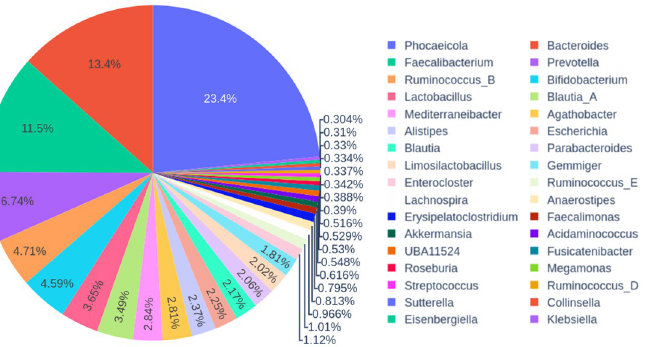
Fig 2. Piechart summarizing the taxonomic composition at the genus level for the top 100 highly expressed genomes. Phocaeicola is the most abundant phylum (23.4%, purple), followed by Bacteroides (13.4%, red), Faecalibacterium (11.5%, green), and the rest can be followed by reading left to right in the legend and counter- countwise accordingly in the graph.